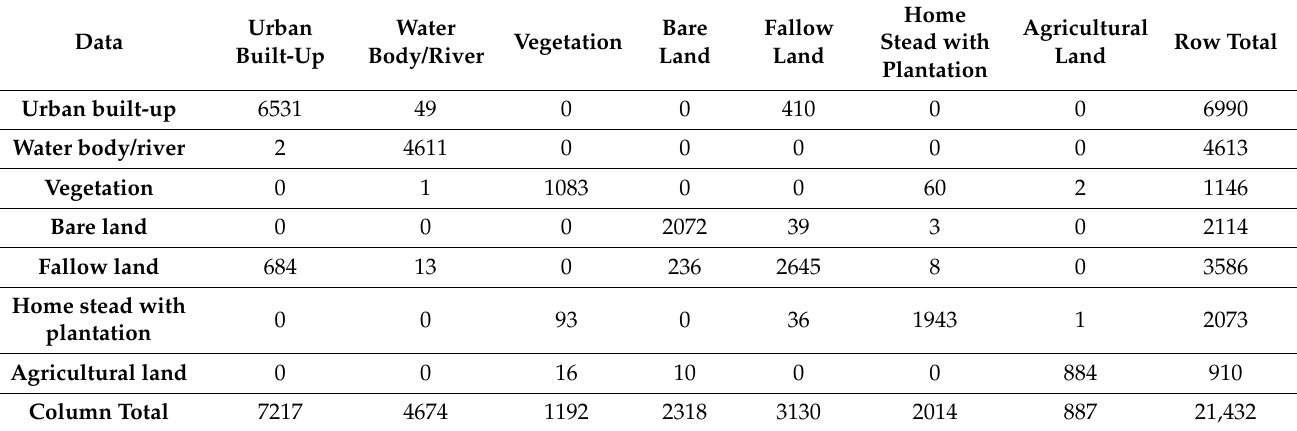
Table 5. Contingency matrix for land use and land cover, 2019.